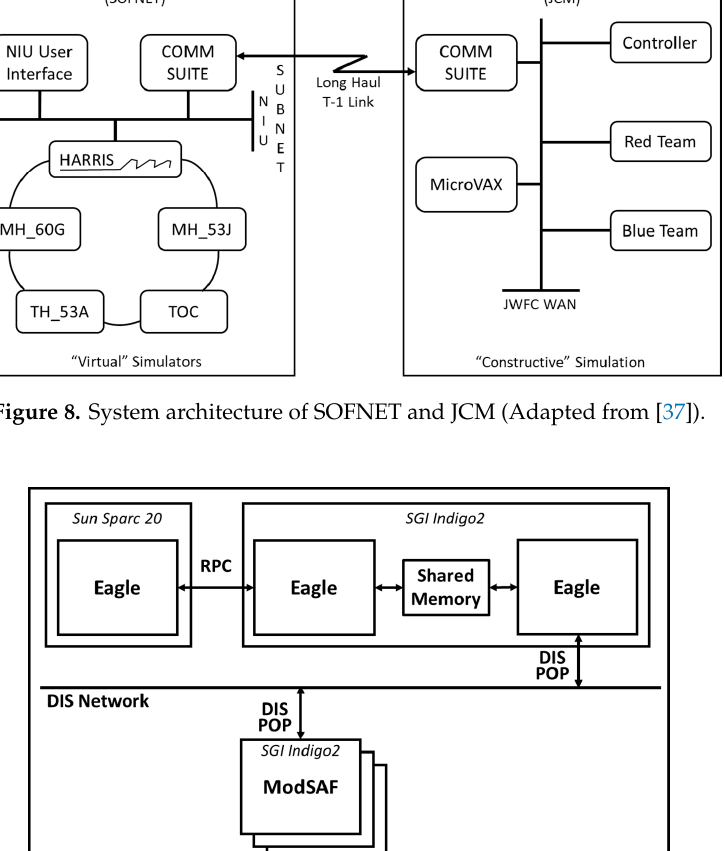
Figure 8. System architecture of SOFNET and JCM (Adapted from [37]).